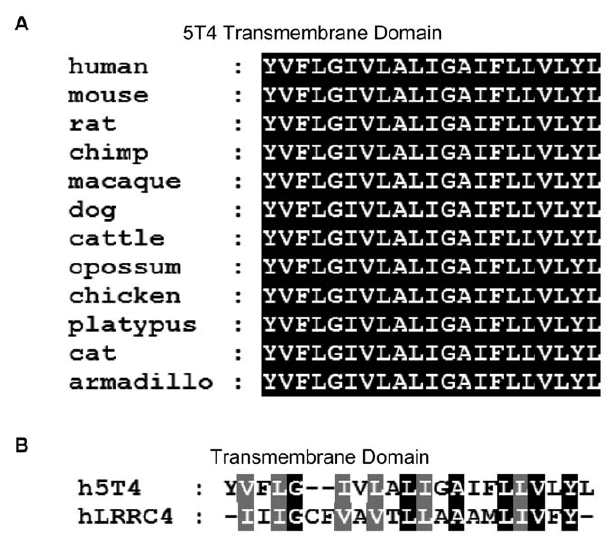
Figure 12. Sequence comparison of 5T4 TM domains. Align- ments were performed using the ClustalW2 multiple sequence alignment program (EMBL-EBI) to compare (A), the TM domains of 5T4 across species and (B), the TM domain of human 5T4 with human LRRC4, identical residues shaded black, similar residues shaded grey.